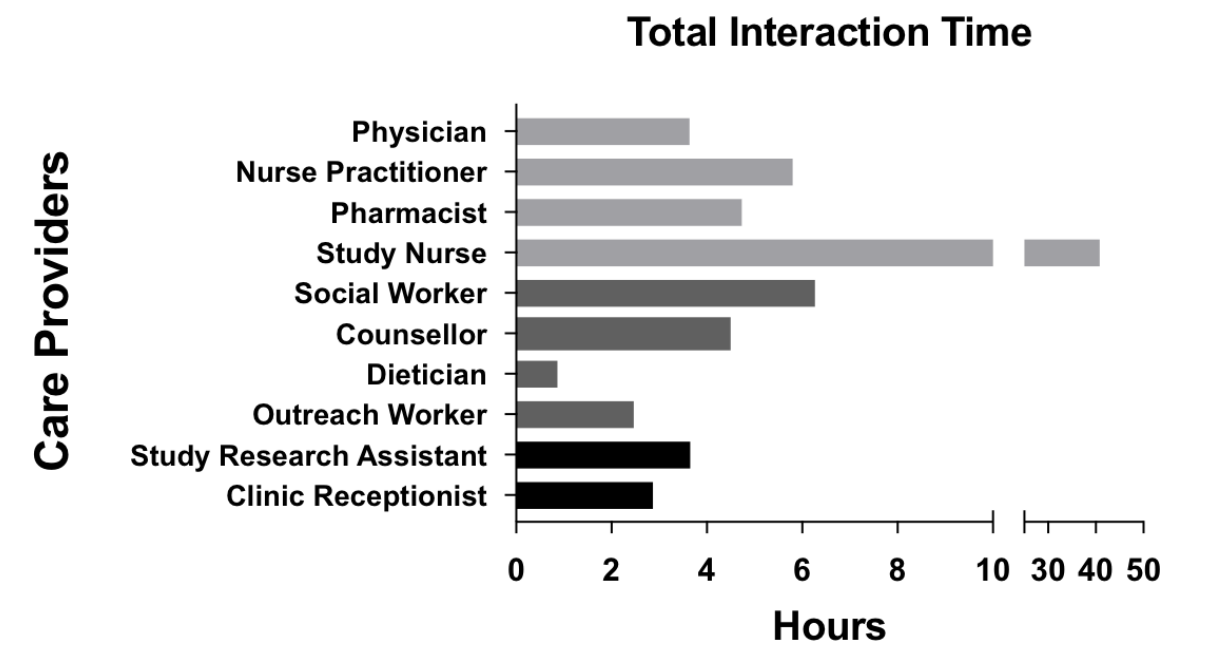
Figure 4. Total interaction time per health care provider over study year.